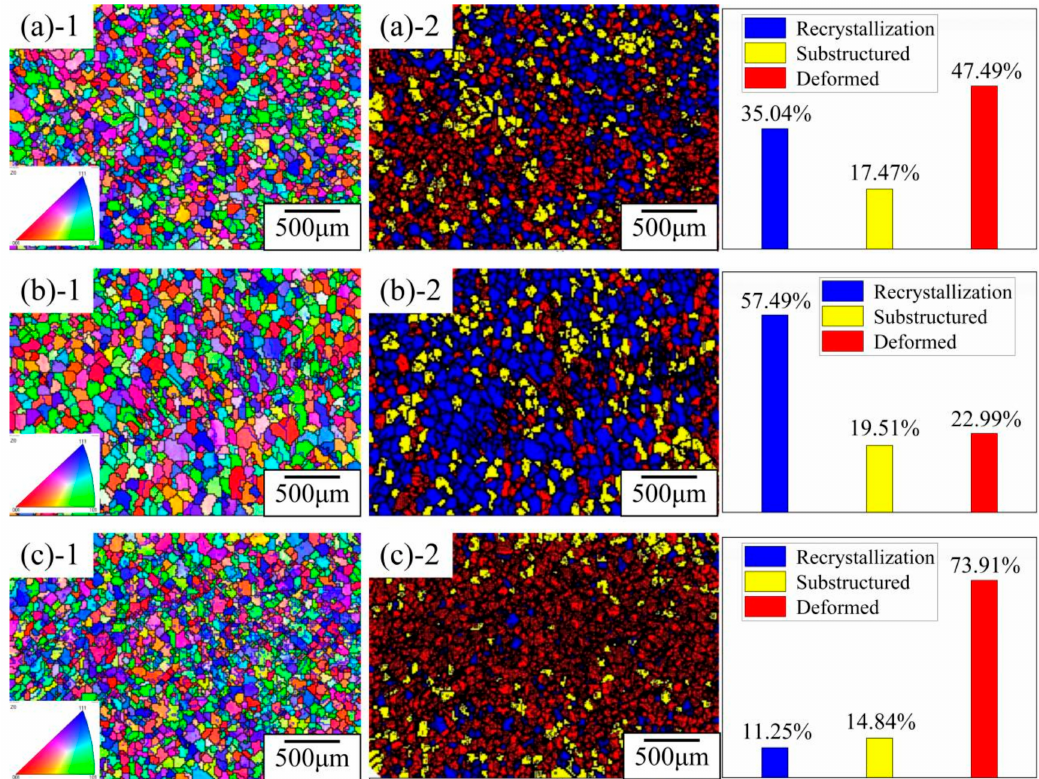
Figure 9. Electron back-scatter diffraction (EBSD) orientation maps and recrystallization diagram at the bottom of specimens from different processes. ( a ) No change of heat input and no cooling (Specimen A). The grain size is between 13.5 µ m and 174 µ m, and the average grain size is 47 µ m. ( b ) No change of heat input, cooling between layers (Specimen B). The grain size ranges from 9.95 µ m to 171 µ m, and the average grain size is 48 µ m. ( c ) Change of heat input without inter-layer cooling (Specimen D). The grain size ranges from 13.5 µ m to 144 µ m, and the average grain size is 43 µ